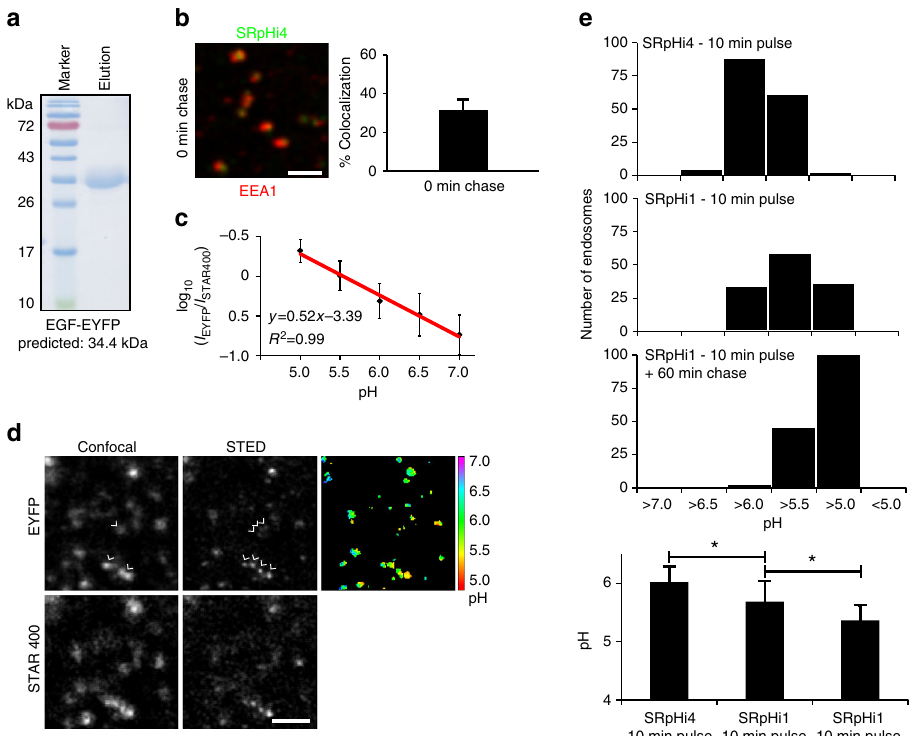
Fig. 6 SRpHi probes can be fused to endogenous ligands. a The identity and purity of SRpHi4 was con fi rmed by SDS-PAGE and Coomassie stain. SRpHi4 consists of a C-terminal fusion of mature human EGF to EYFP. Additionally, SRpHi4 is conjugated to the STAR400 dye. b SRpHi4 ( green ) was loaded into CV-1 cells for 10 min followed by fi xation and immunostaining against the early endosomal marker EEA1 ( red ). Colocalization between SRpHi4 and EEA1 was calculated as in Fig. 2. c CV-1 cells pulsed with SRpHi4 for 10 min were equilibrated to the indicated pH by application of an external citric acid/ phosphate buffer supplemented with 140 mM KCl and 1 µ M nigericin. Two-channel (STAR400 and EYFP) confocal and STED imaging was performed. The STED STAR400 image was used to produce a mask of all endosomes and the ratio of EYFP/STAR400 signal was calculated in each endosome ( n > 150 endosomes for each pH value), averaged for each pH value, and their log 10 values plotted. Log 10 EYFP/STAR400 values were fi t to a linear equation ( R 2